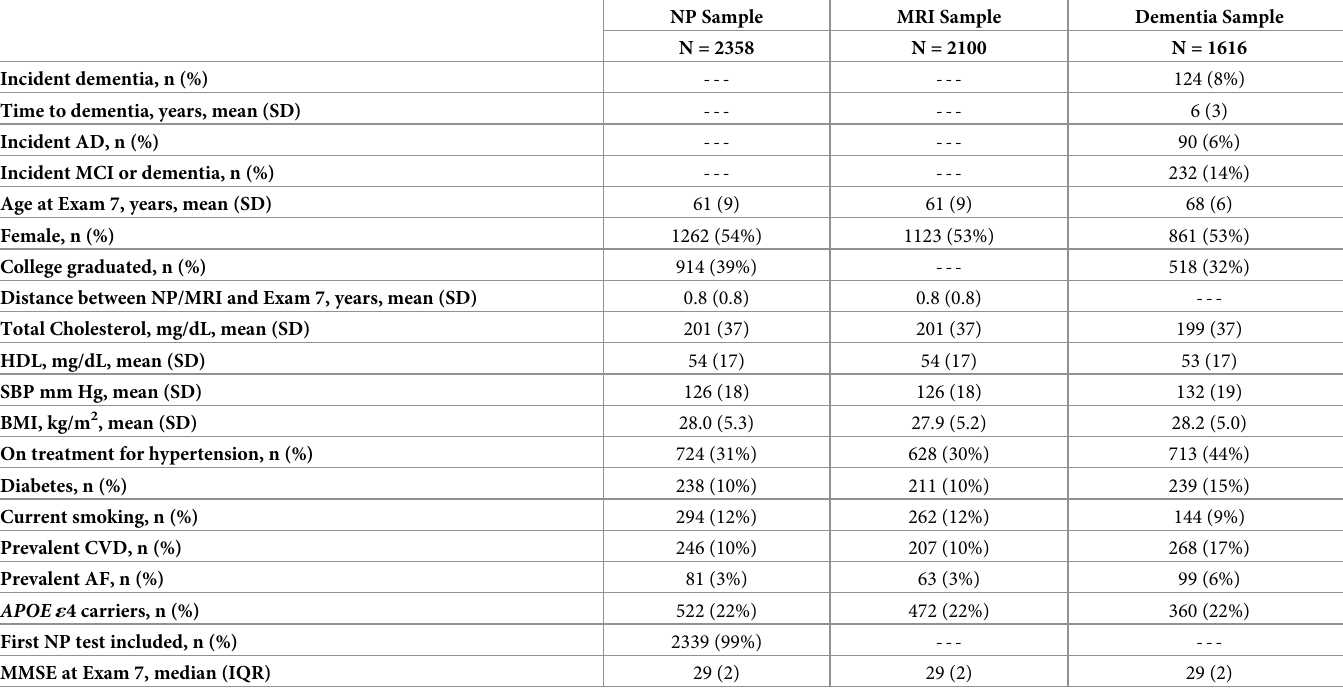
Table 1. Participant characteristics of the incident dementia, neuropsychological (NP) test, and brain MRI